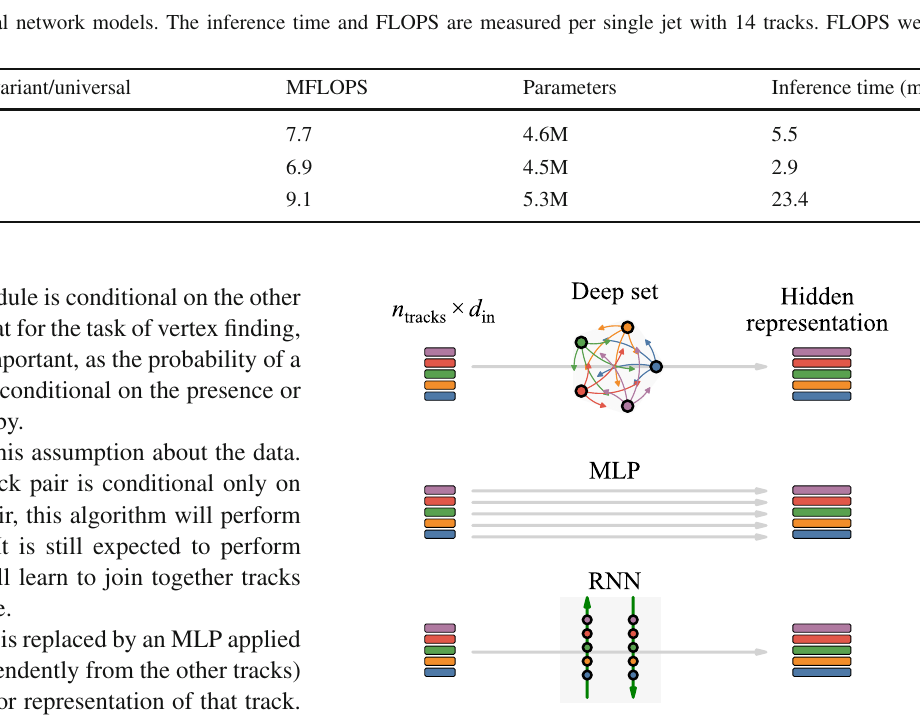
Fig. 5 The deep set module φ in the S2G model (top) creates the trackhidden representationbased oninformation exchange betweenthe tracks in the jet. The TP classifier (center) however, creates the hidden representation with an MLP, which operates on each track individually. The RNN model (bottom) creates the hidden representation with a bi- directionalGRU,whichmeanstheoutputdependsontheorderinwhich the tracks are